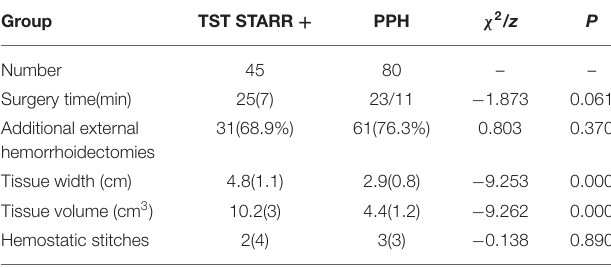
TABLE 1 | Characteristics of the patients.